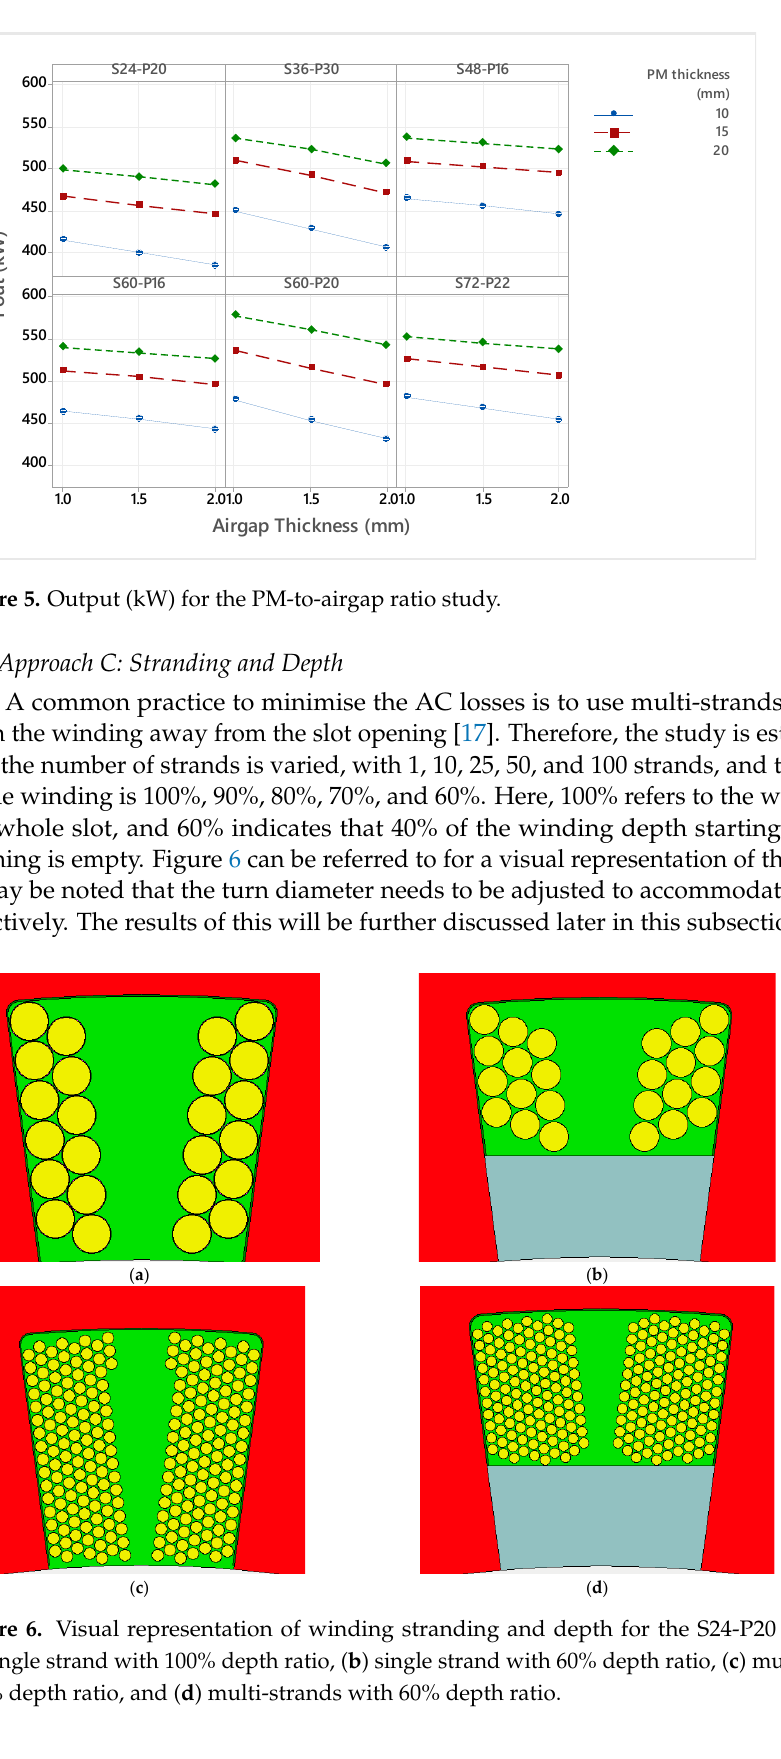
Figure 6. Visual representation of winding stranding and depth for the S24-P20 as an example, ( a ) single strand with 100% depth ratio, ( b ) single strand with 60% depth ratio, ( c ) multi-strands with 100% depth ratio, and ( d ) multi-strands with 60% depth ratio.